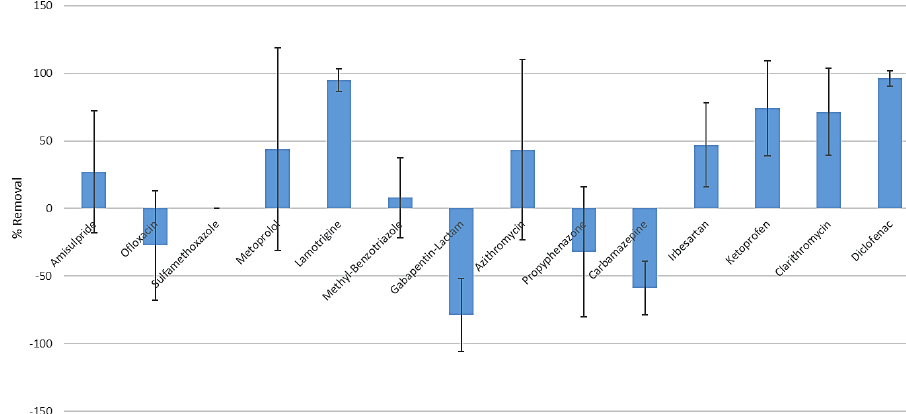
Fig.4. Percent removal of the tested compounds in the MBP pilot raceway (average and standard deviations). Negative values correspond to higher concentrations in the effluent than in the